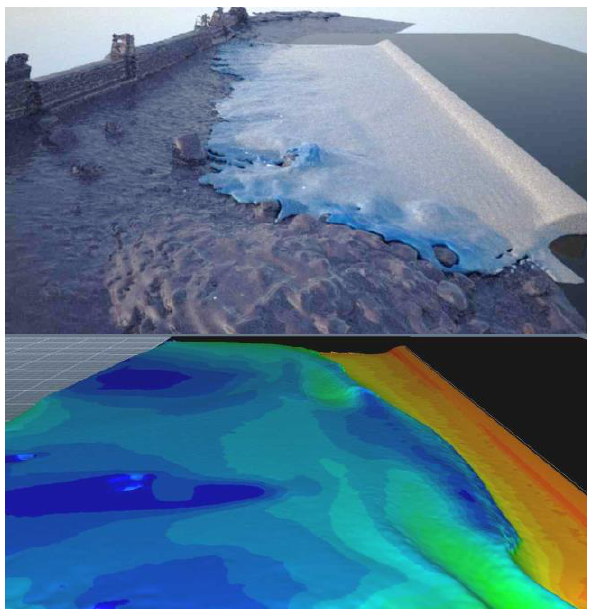
Figure 3. 3D simulations of effect of beach morphology on tidal dynamics. The upper images show a 3D smoothed particle hydrodynamics simulation running on our 1cm resolution intertidal dataset. The lower image shows one of our simulations modified to show velocity gradients as the water interacts with variable beach morphology.